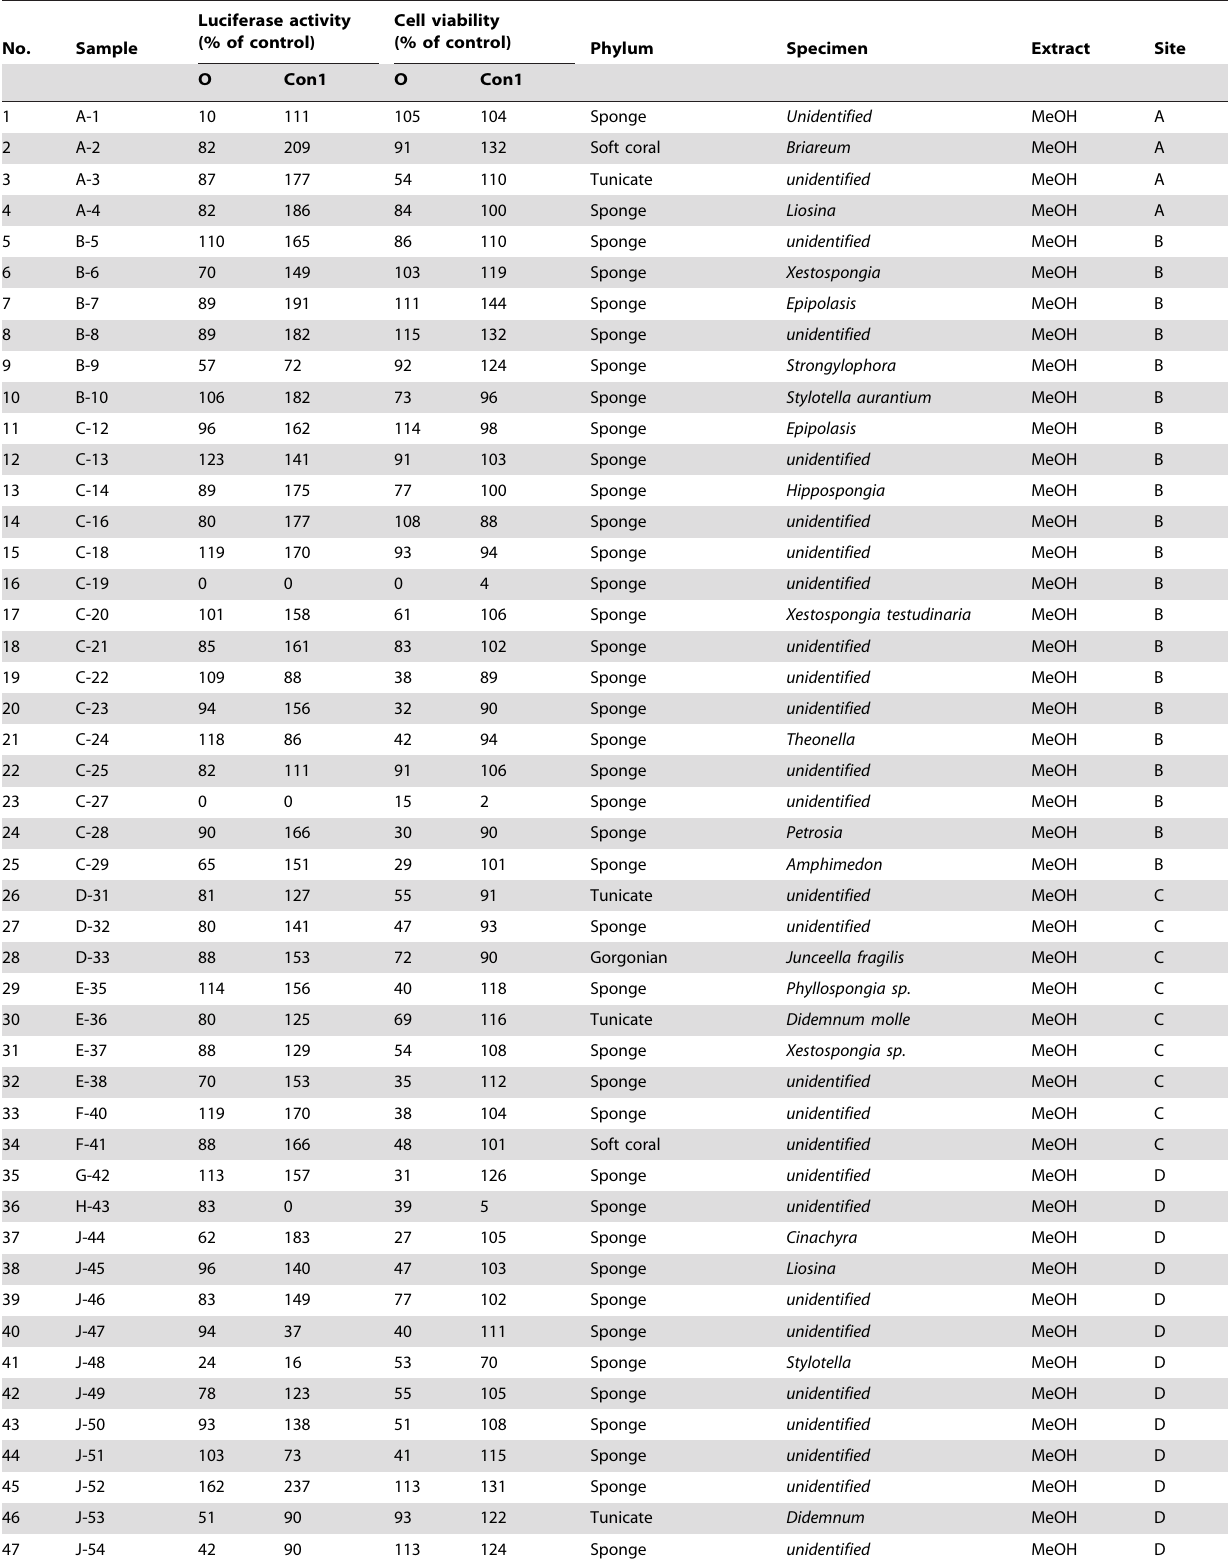
Table 1. Effect of marine organism extracts on HCV replication and cell viability.